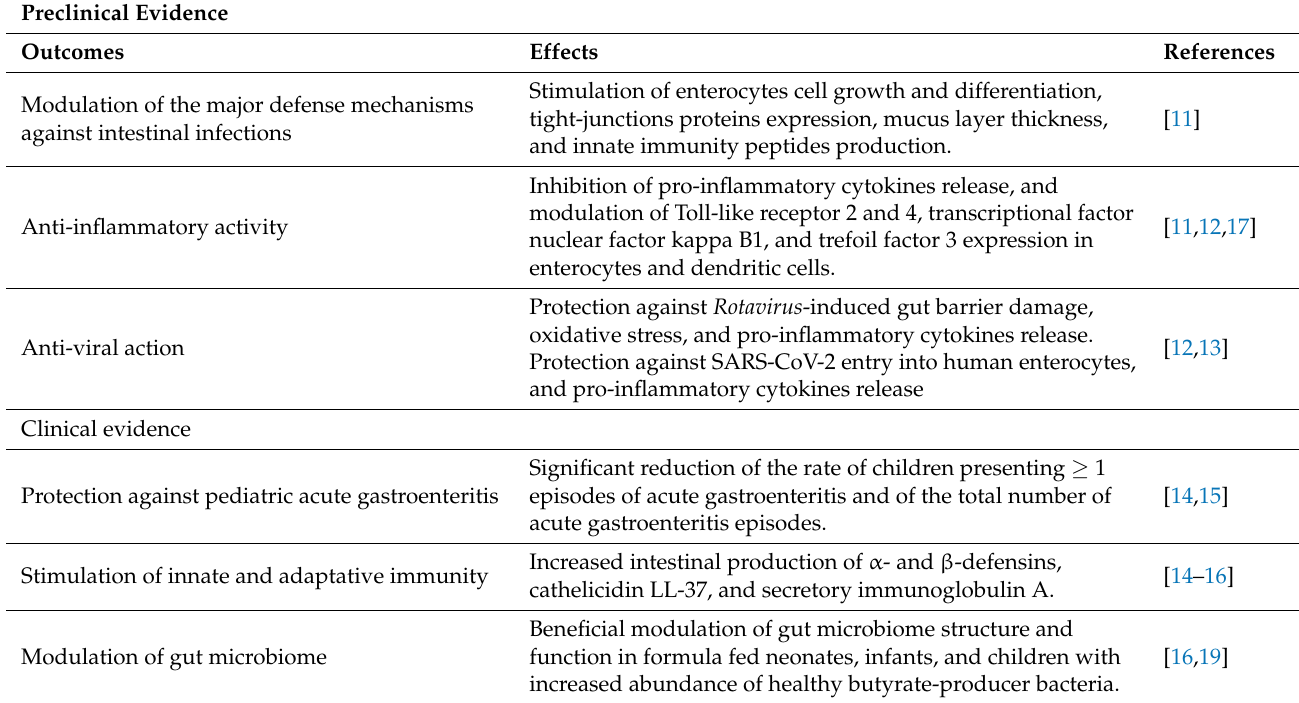
Table 1. A summary of the most relevant preclinical and clinical evidence on the protective action elicited by the postbiotic FM-CBAL74 against pediatric intestinal